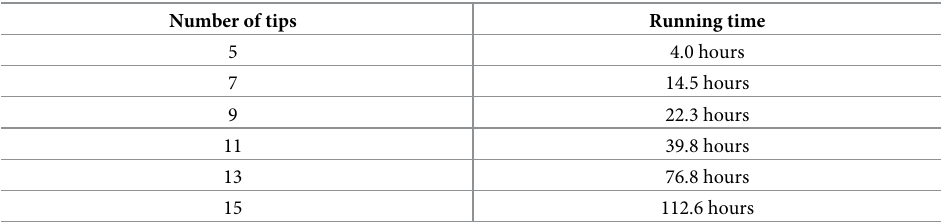
Table 1. Average running time of AFPhyloMix on the simulated data